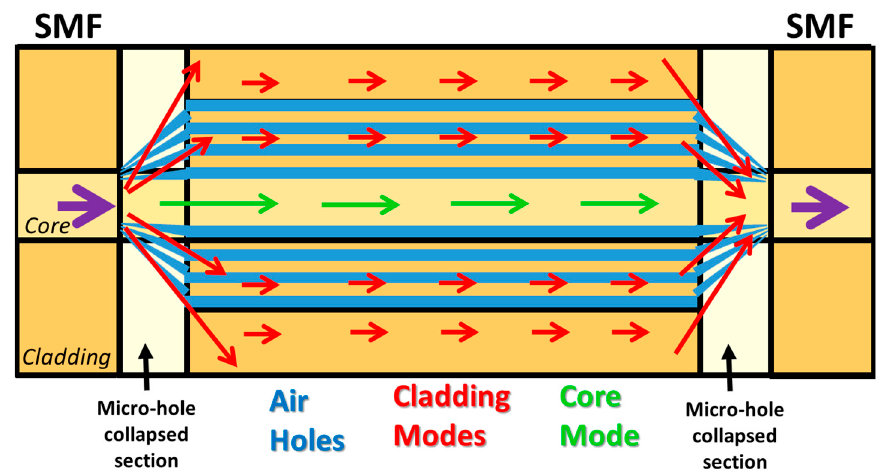
Figure 12. Operating mechanic of the Mach–Zenhder (MZ) interferometer based on SC-PCF. The arrows show the behavior of the cladding and core modes trough the SC-PCF; in blue are drawn the holes of the SC-PCF and in black the micro-hole collapsed sections.